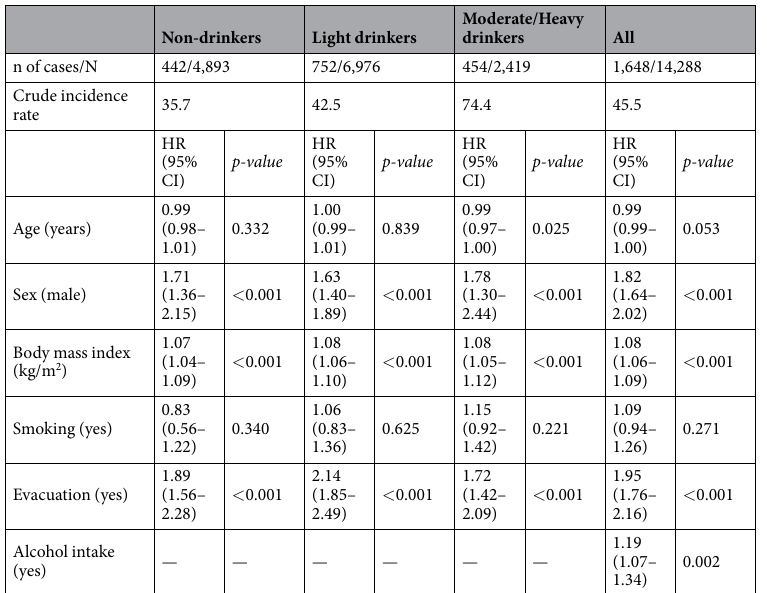
Table 2. Incidence rates and hazard ratios (95% confidence interval) of hepatobiliary enzyme abnormality for variables among 14,288 participants without hepatobiliary enzyme abnormality in 2011–2012. n indicates number; N, number of participants; CI, confidence interval. Crude incidence rate (per 1000